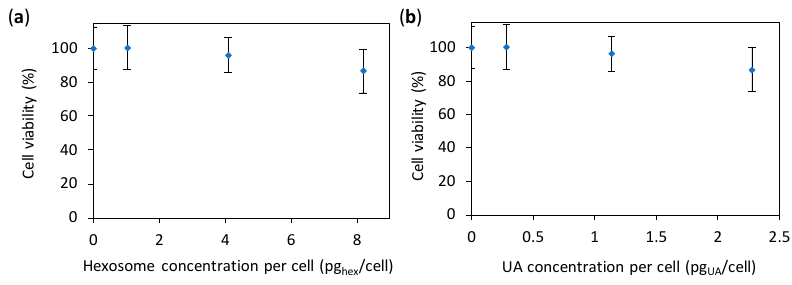
Figure 6. Viability of human A594 cells incubated for 24 h with different concentrations of hexosomes measured with the MTS test. The cell viabilities are given as percentages of viable cells treated with hexosomes (whose absorbance was corrected for the absorbance of hexosomes) normalized with the number of viable cells treated with media without hexosomes (0% hexosomes). The results are given as a function of: ( a ) the concentration of hexosome per cell; and ( b ) the concentration of undecylenic acid (UA) per cells; all values are given as the mean ± standard